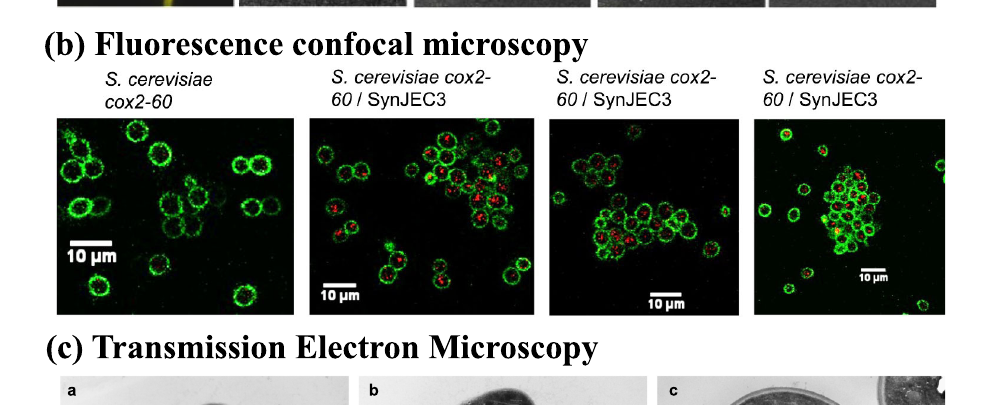
for the green fl uorescent light from the Con A-FITC dyes on yeast cells and the red auto fl uorescence from cyanobacterial cells. Both yeast cells and cyanobacterial cells could therefore be spectrally separated and imaged simultaneously (see Supplementary Fig. 3).